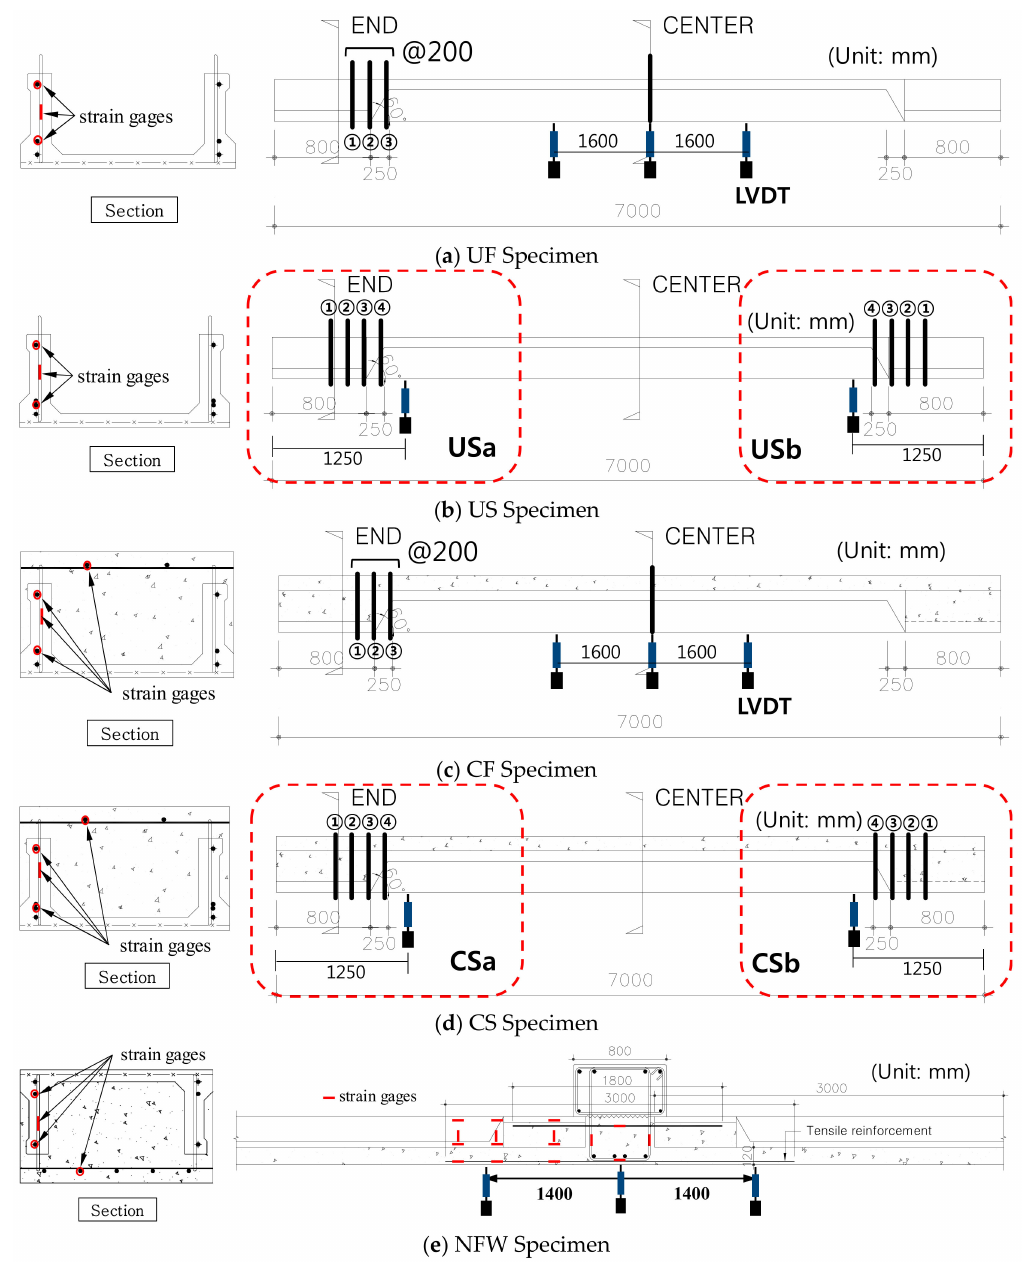
Figure 8. Measurement of the strains and deflection (Unit: